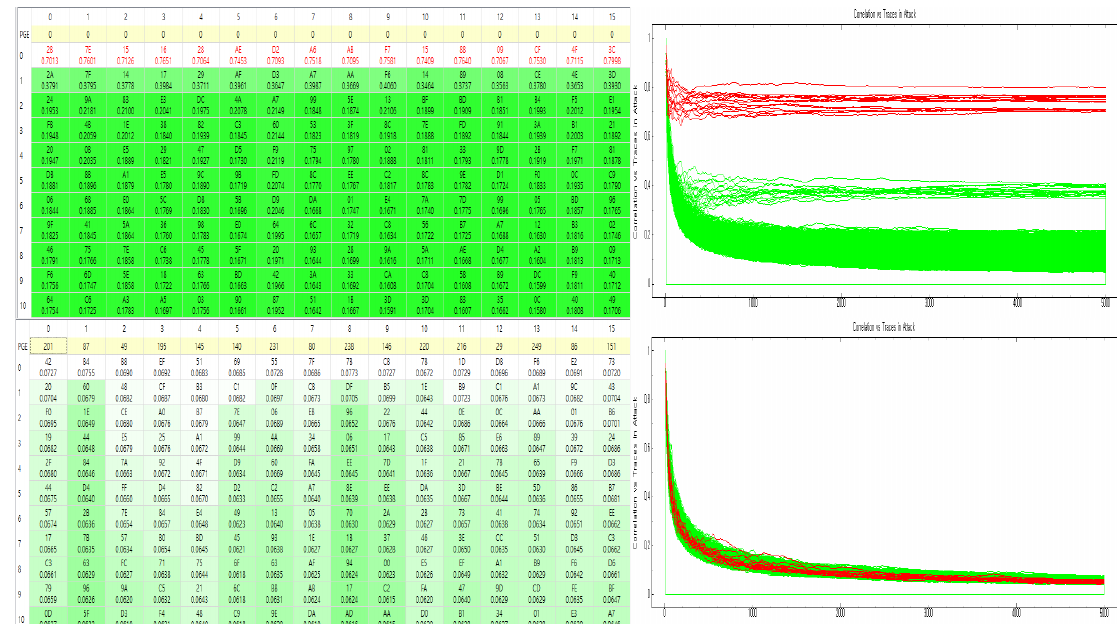
Figure 3. CPA (Correlation Power Analysis) attack result comparison between non-masked AES and masked FACE-LIGHT implementations, ( Top ) analyzed key value table of non-masked AES through CPA attack and graphical result of correlation of key values via CPA attack on non-masking AES, ( Bottom ) analyzed key value table of masked AES through CPA attack and graphical result of the correlation of key values via CPA attack on masked AES.